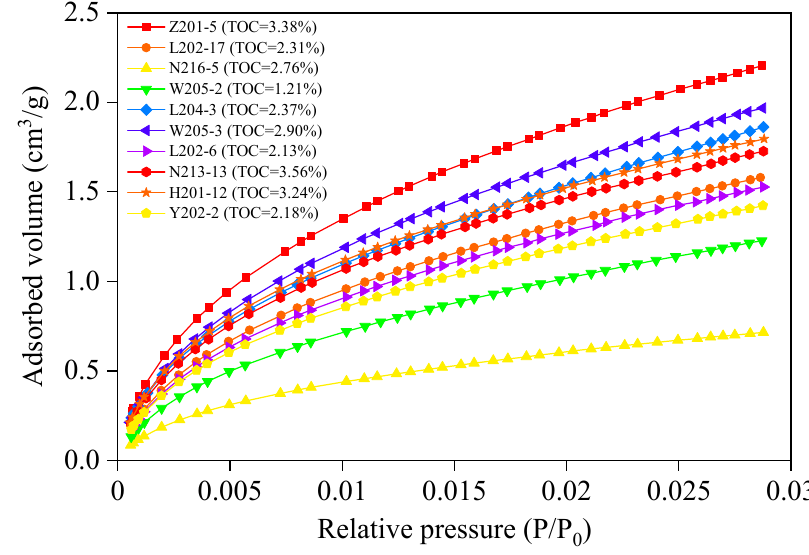
Figure 5. FE-SEM images of organic matter pores in Longmaxi shale samples. ( A , B ) Organic matter pores associated with clay mineral, Sample N213-13; ( C ) Organic matter pores within clay aggregates, Sample N213-13; ( D ) Pores in strip shaped organic matter, Sample N213-13; ( E ) Pores in isolated organic matters, Sample L202-17; ( F ) Strongly connected organic matter pores, Sample L202-17; ( G ) Slightly aligned organic matter pores, Sample L204-3; ( H ) Organic matter pores within pyrite framboid, Sample N213-13; ( I ) Complex organic matter pores, Sample H201-12; ( J ) Pores in isolated organic matter, Sample L202-17; ( K , L ) Organic matter pores associated with clay minerals, Sample Y202-2.